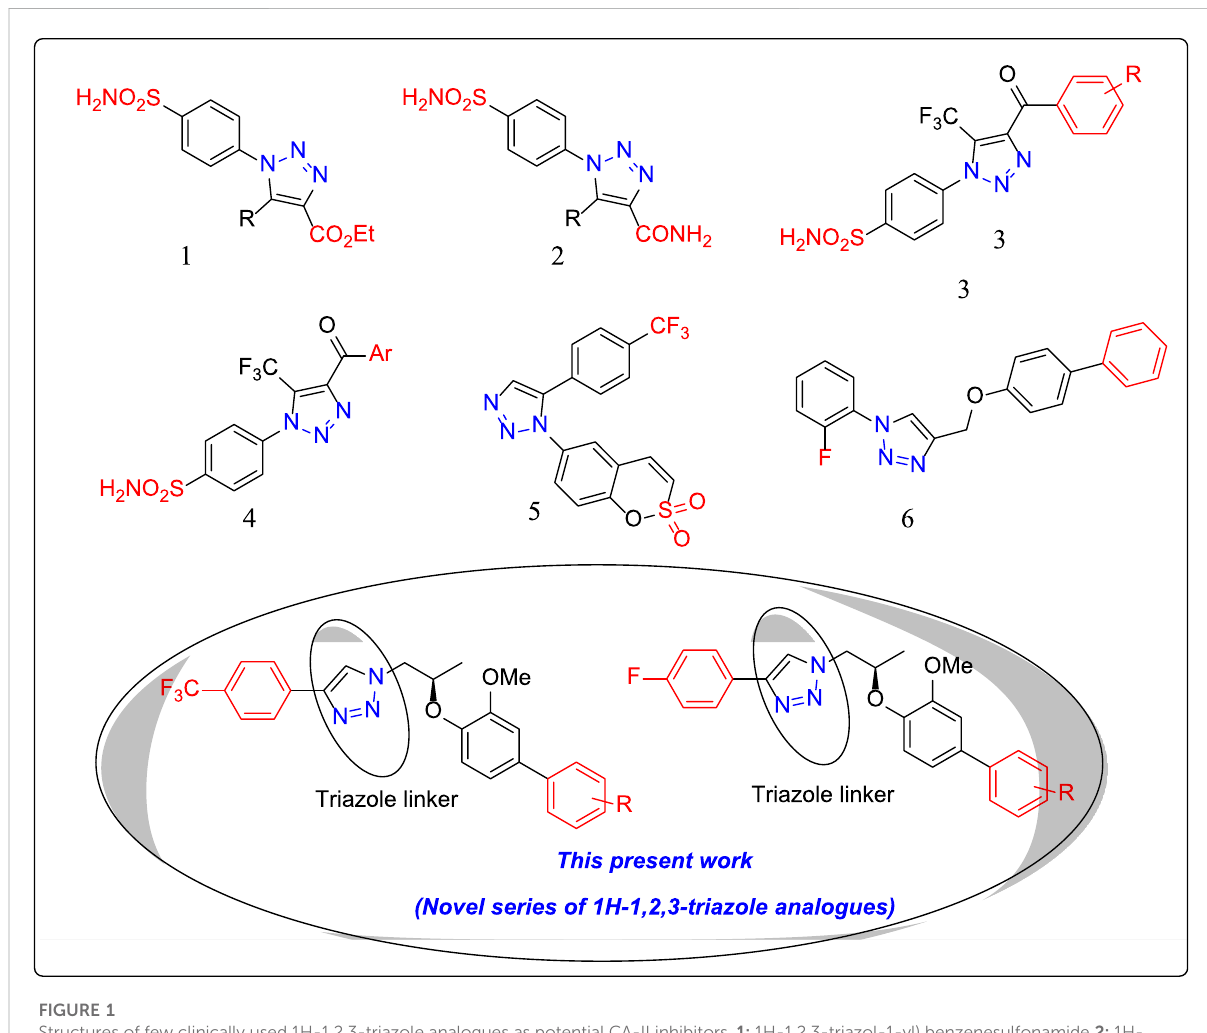
FIGURE 1 Structures of few clinically used 1H-1,2,3-triazole analogues as potential CA-II inhibitors. 1: 1H-1,2,3-triazol-1-yl) benzenesulfonamide 2: